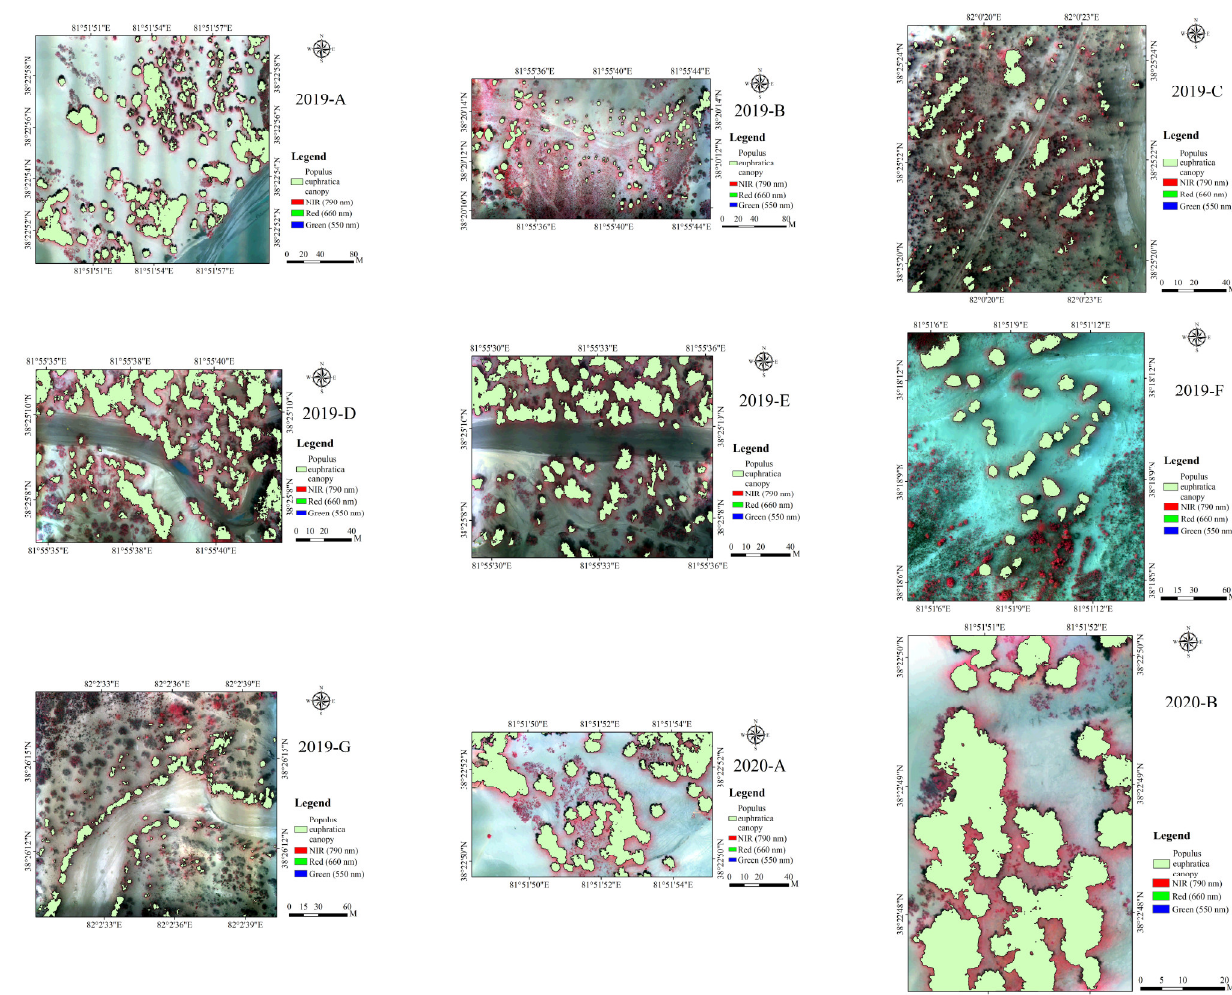
Figure 7. Overlay of Populus euphratica crown vectorization result for each